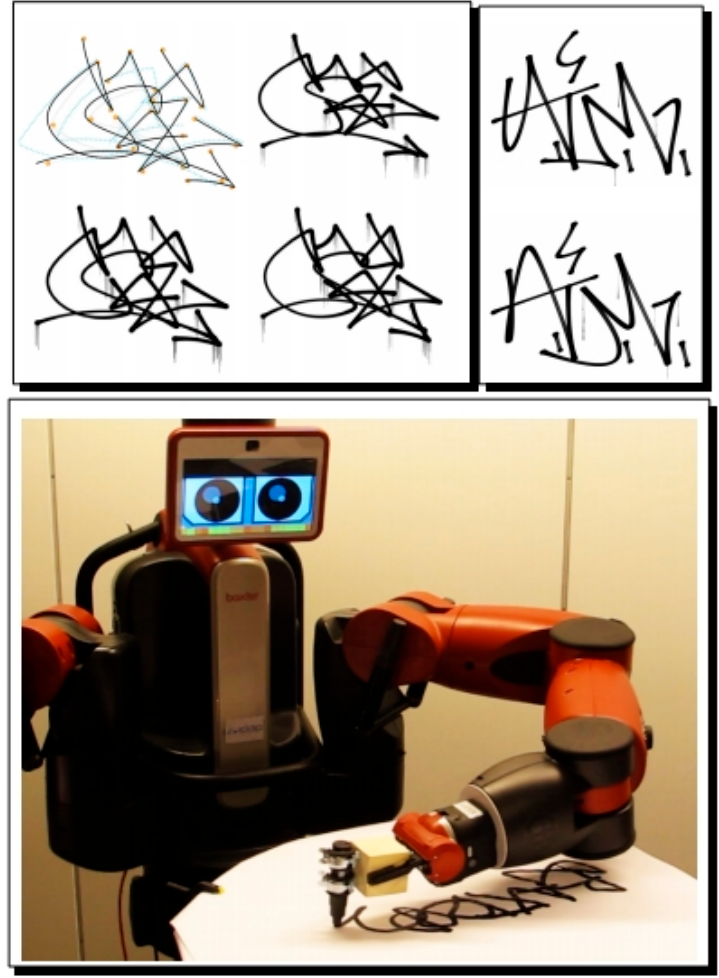
Figure 7. Examples from the AutoGraff project. Top-Left : graffiti tags with same targets or aiming loci (yellow dots, top-left) and 3 variants obtained by changing the speed profiles of each gesture (one per pair of successive targets). Top-right : Two versions of tags (with same targets, but different speed profiles) for “A.I.M.”. Bottom : The Baxter “compliant” robot capable of writing its own name in the style of graffiti tags (Berio 2021).